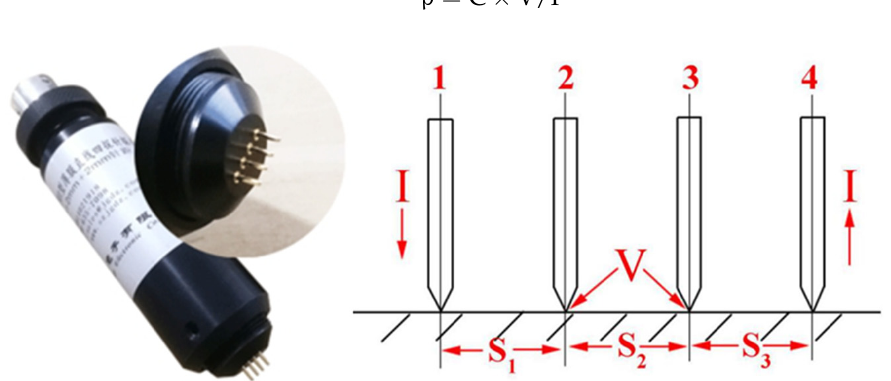
Figure 1. Schematic diagram of resistivity measurement by four-probe method.